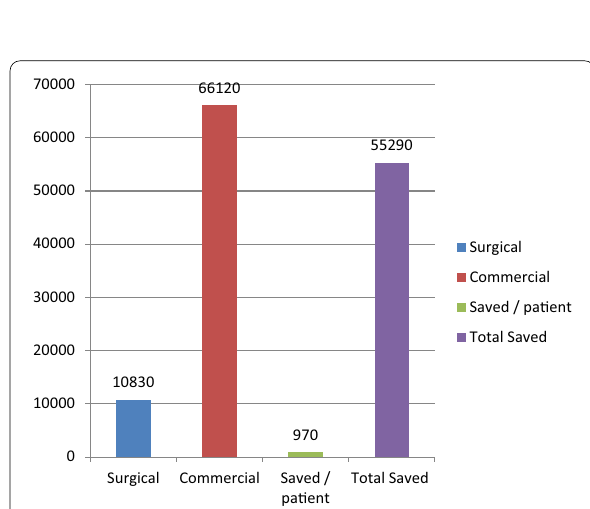
Fig. 5 Cost of surgical clips (LE) among study